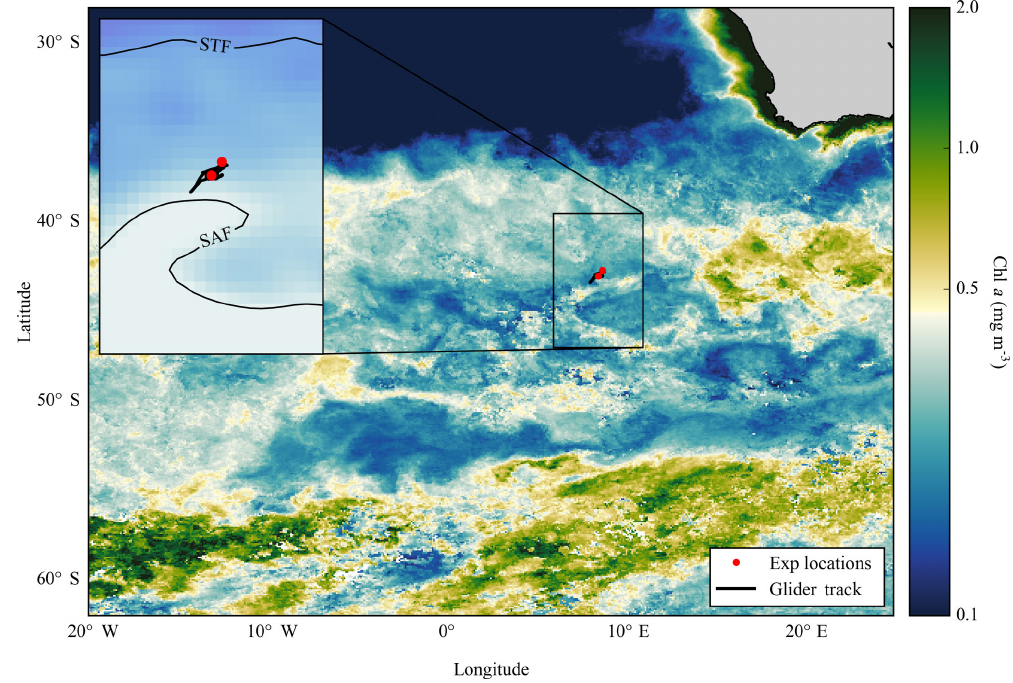
Figure 1. Composite map of MODIS (8 day, 9km) derived Chl a (mgm − 3 ) from December 2015 to February 2016 for the Atlantic sector of the Southern Ocean, with locations of nutrient addition incubation experiments and the glider track. Inset composite map of absolute dynamic topography (MADT) from the CLS/AVISO product (Rio et al., 2011) from December 2015 to February 2016 with boundary definitions of subtropical front (STF) and sub-Antarctic front (SAF) (Swart et al., 2010), with locations of experiments and glider